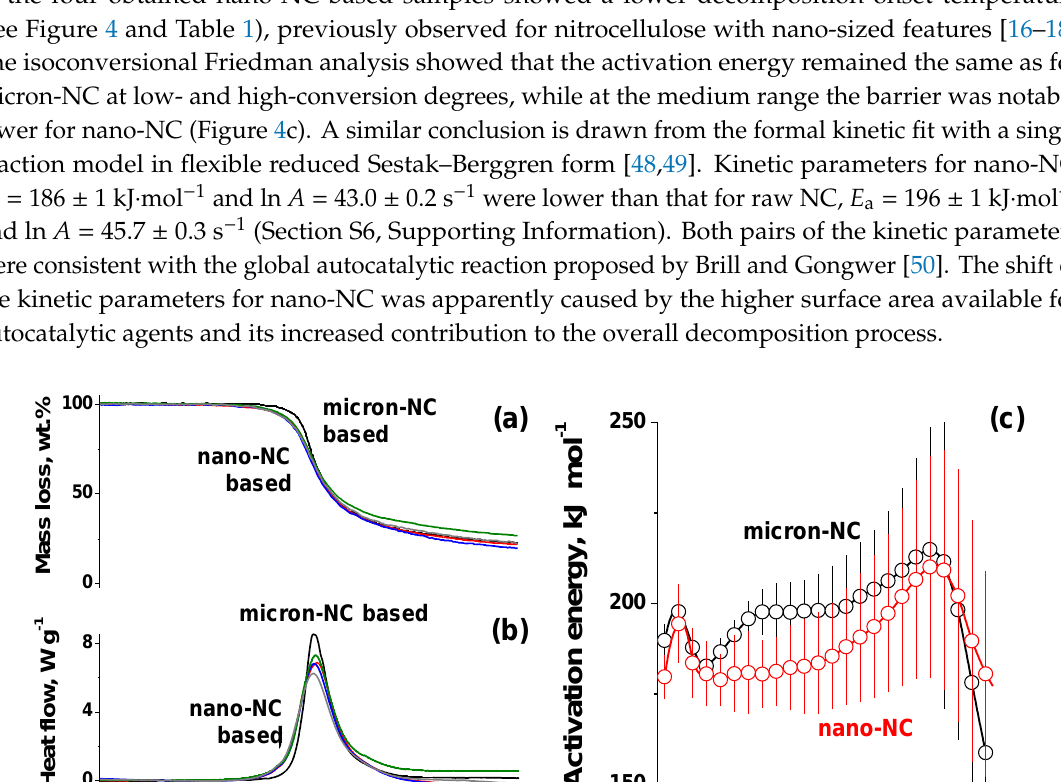
Figure 3. Electron microscopy of ( a ) NC/carbon nanotube (CNT)(sc) and ( b ) NC/CNT/Fe 2 O 3 (sc) .